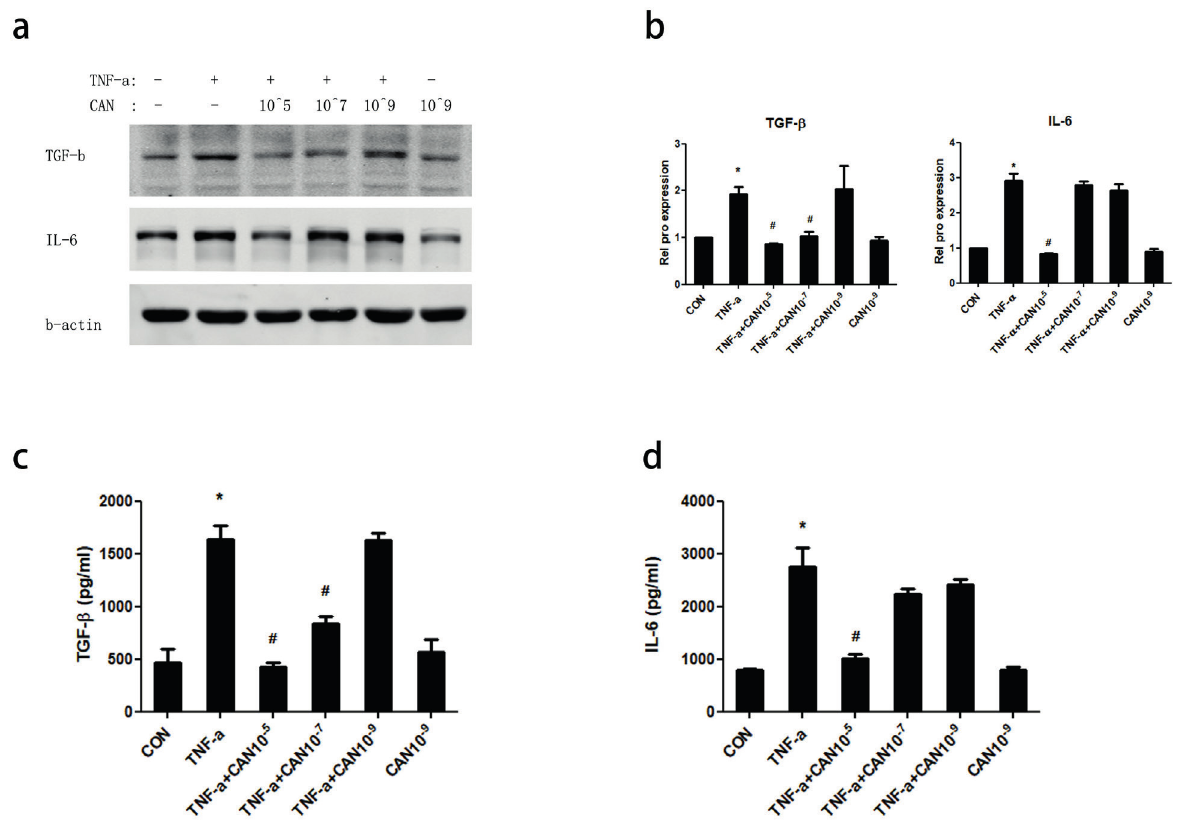
Figure 1 - Candesartan suppresses TNF- α induced expression of TGF-β and IL-6. HKC were treated with TNF- α (2ng/ml), or TNF- α combined with different dosages of candesartan for 24 hours. Then cell lysates were prepared and subjected to immunoblot analysis with antibodies to TGF-β or IL-6. Representative Immunoblots from three or more experiments are shown ( a ). Expression levels of the indicated proteins were quantified by densitometry and normalized with β-actin ( b ). Conditional media from cultured cells were collected and TGF-β ( c ) or IL-6 ( d ) levels were determined by ELISA (n=3). P<0.05 vs. CON, #P<0.05 vs. TNF- α treatment; CON: control, CAN: